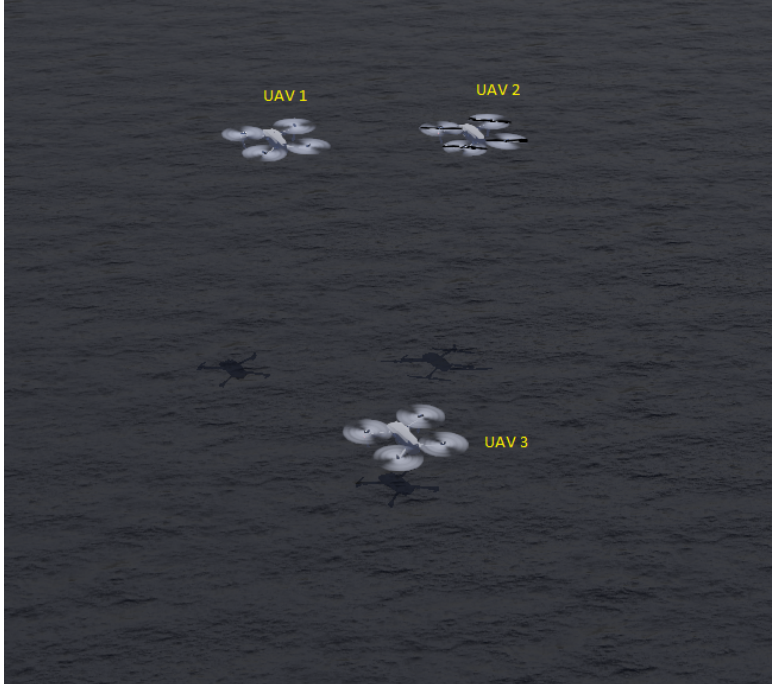
Figure 10. An illustration of multi-robot pursuit–evasion scenario where UAVs 1 and 2 have captured and “grounded” UAV 3, which is an evader